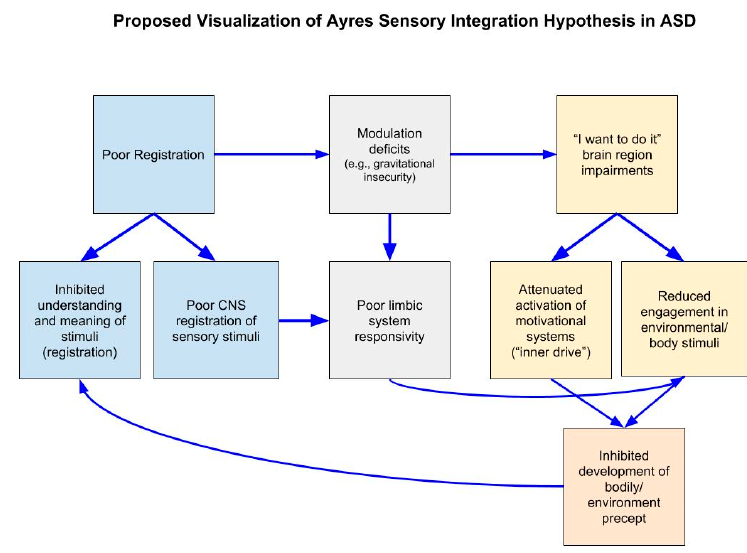
Figure 2. A proposed visualization of Ayres Sensory Integration Hypothesis in autism spectrum disorders (ASD). CNS: Central nervous system.